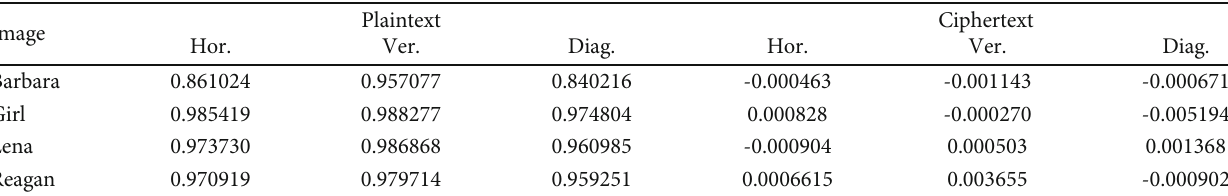
Table 2: Correlation coe ffi cients.